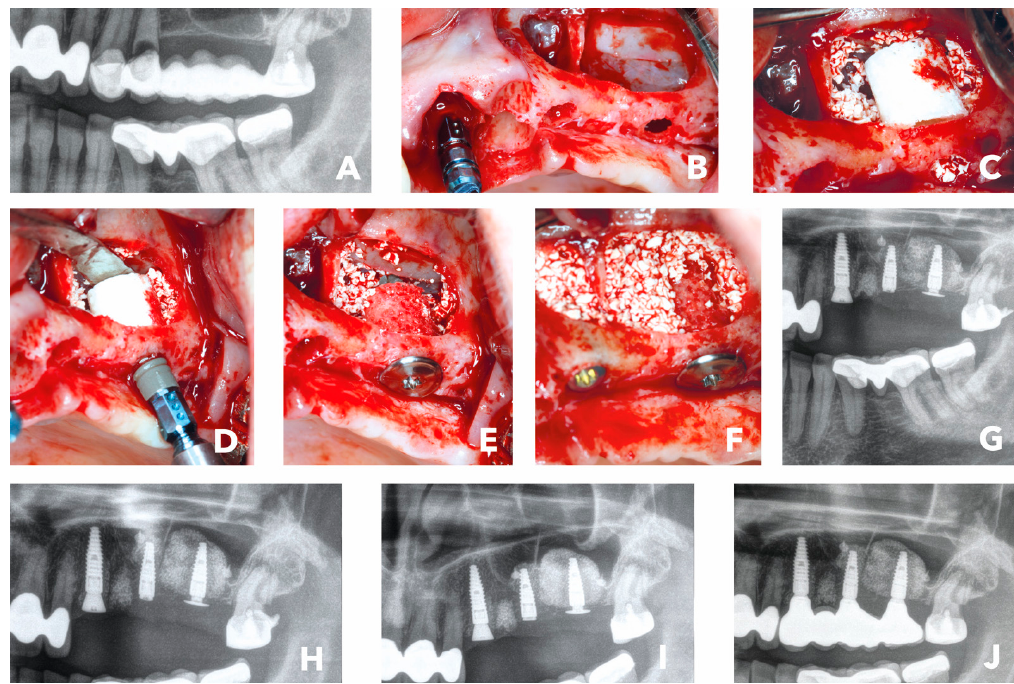
Figure 4. ( A ) Initial situation: Radiological image of bridge retained second quadrant with hopeless teeth #23 and #24. ( B ) External sinus floor elavation and implant placement #23. ( C ) Placement of a 7-mm bone ring block #27 and bovine bone substitute. ( D ) Implant placement. ( E ) Crestal placement of a fication screw to secure the bone graft and implant. ( F ) Implant placement in #25 and sinus cavity filled with bovine bone substitute. ( G ) Post-op x-ray. ( H ) Radiographical control 6 months after surgery. ( I ) Radiographical control 1 week later when the implants were uncovered and prosthodontic impression made. ( J ) Radiographical image of final prosthetic restoration 6.5 months after initial surgery.